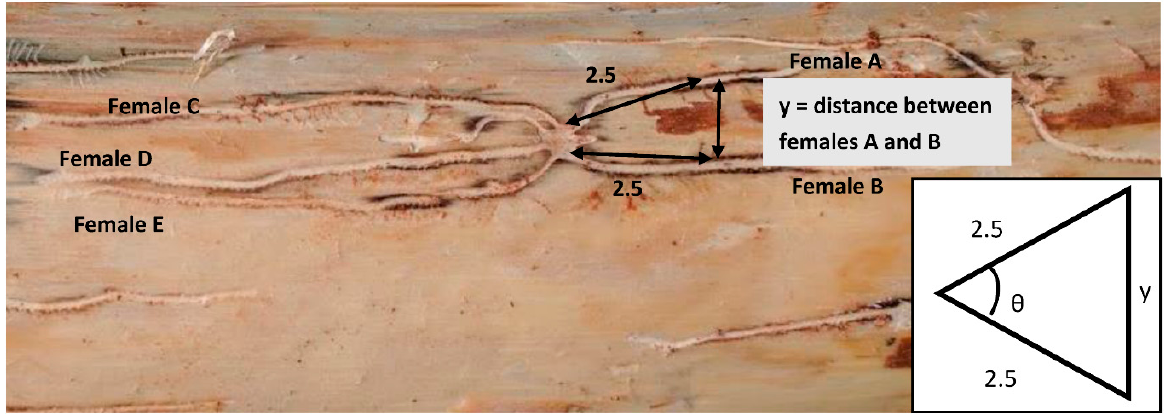
Figure 2. Example of Ips grandicollis harem showing a central male nuptial chamber and the galleries of five females radiating outwards. The arrow marked with a y indicates where measurements between two females were taken from. θ = the angle calculated in to incorporate into a proximity index (see below).